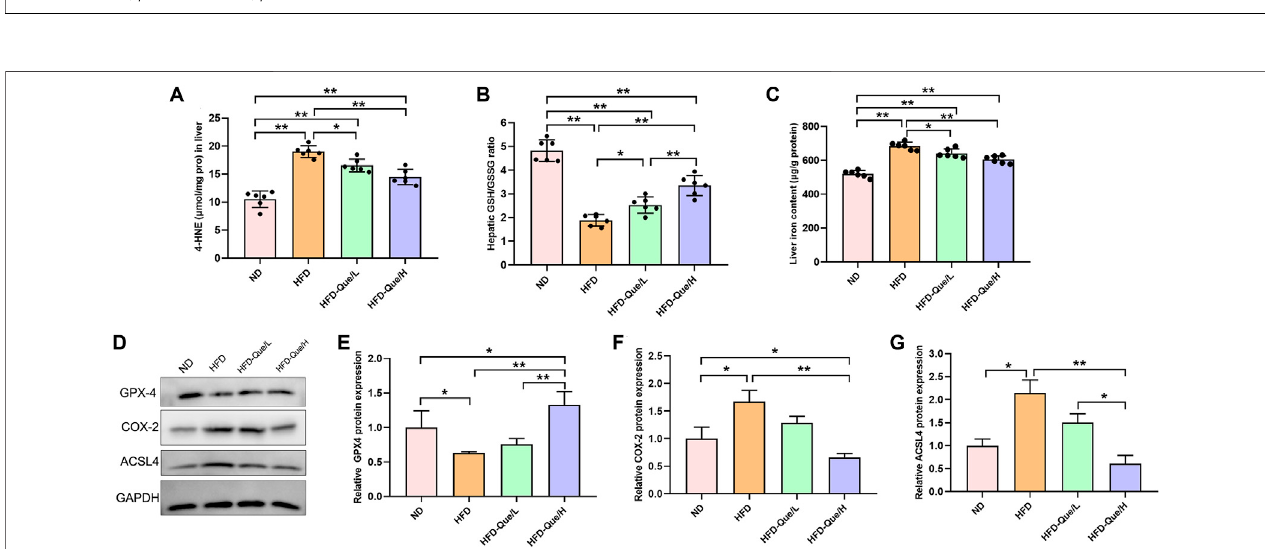
FIGURE 3 | Que reduced lipid peroxidation and ferroptosis in the livers of HFD-fed mice. (A,B) The levels of 4-HNE and GSH/GSSG in the liver ( n = 6). (C) Iron content in the liver ( n = 6). (D) Representative Western blot images. (E – G) Quantitative analysis of ferroptosis-related proteins (GPX4, COX-2 and ACSL4) in the liver ( n = 3). The data are expressed as the mean ± SD. **, p < 0.01 and *, p < 0.05.